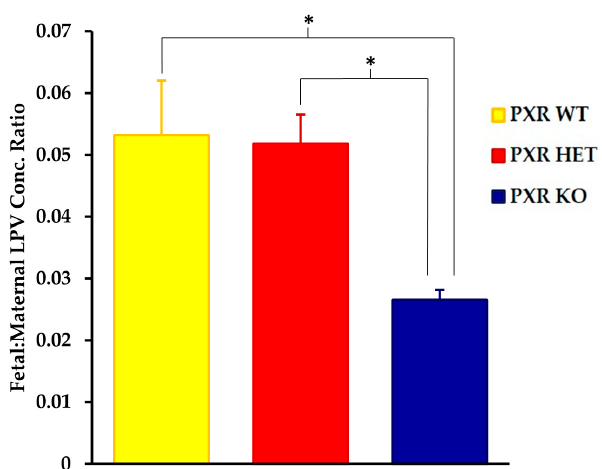
Figure 2. Effect of fetal genotype on LPV accumulation in fetal tissue. LPV concentration ratios were quantified by LC-MS/MS 30 min post-intravenous injection of LPV (10 mg/kg) as stated in the Materials and Methods section. Concentration ratios were calculated as the concentration ratio of LPV in fetal homogenate per unit weight (ng/g) to maternal plasma concentrations (ng/mL). Values are given as mean ratios ± S.E. * p < 0.05. n = 10.